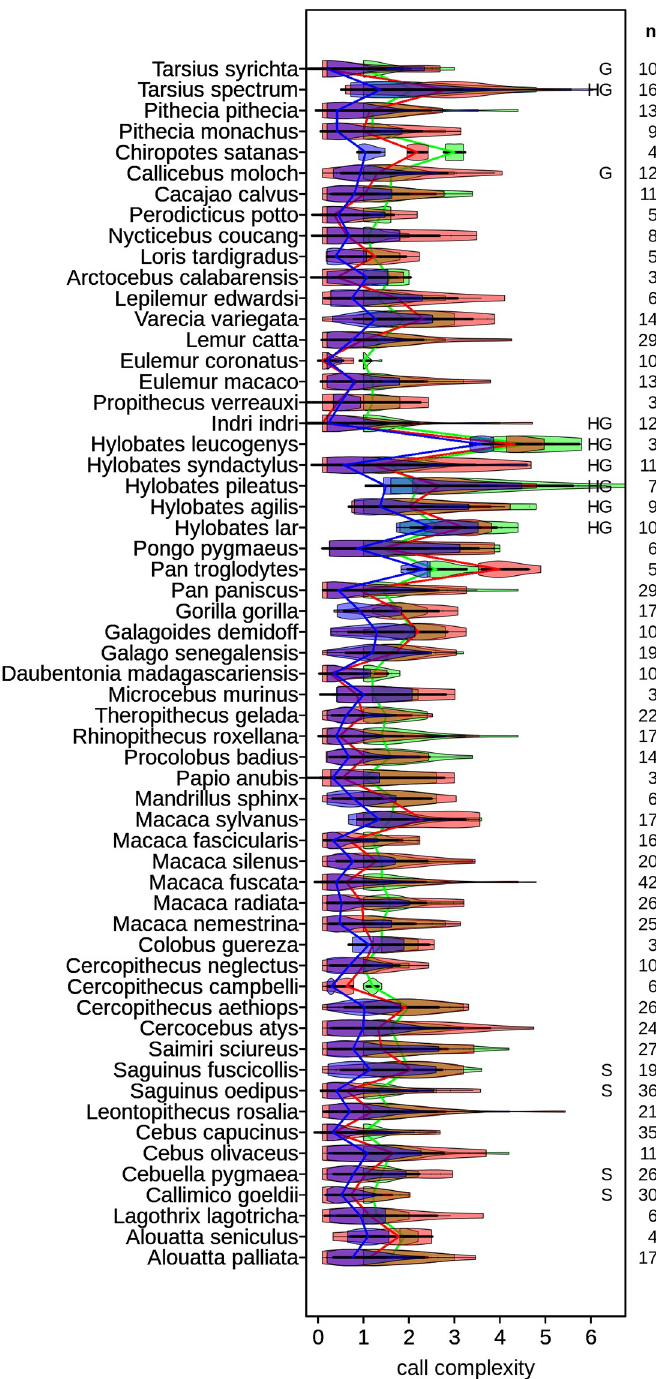
Fig 8. Species level call complexity score distributions for three metrics. ARDI (blue), SCI (red), and syllable count (green) complexity distributions demonstrate how species can have a great diversity of calls whose scores are quite low but have a stand-out call (e.g. Indri ’s song) which scores exceptionally high. Total count of calls in each repertoire is listed under “ n ” on the right. Letters on the right show concordance with Geissman [137], Haimoff [39], and Snowdon [138] who previously explored these primate species for having musical capacities. Note that many new species of primate emerge has potentially possessing music-like calls including galagos, several additional species of lemur, capuchins, squirrel monkeys, multiple leaf monkeys, and even some cheek-pouch monkeys. The higher scoring distributions of the gibbons and chimps are likely due to primary researcher selection bias for recording more display- like calls. Their close / soft calls were likely left truncated out of being included in these distributions. Note that the